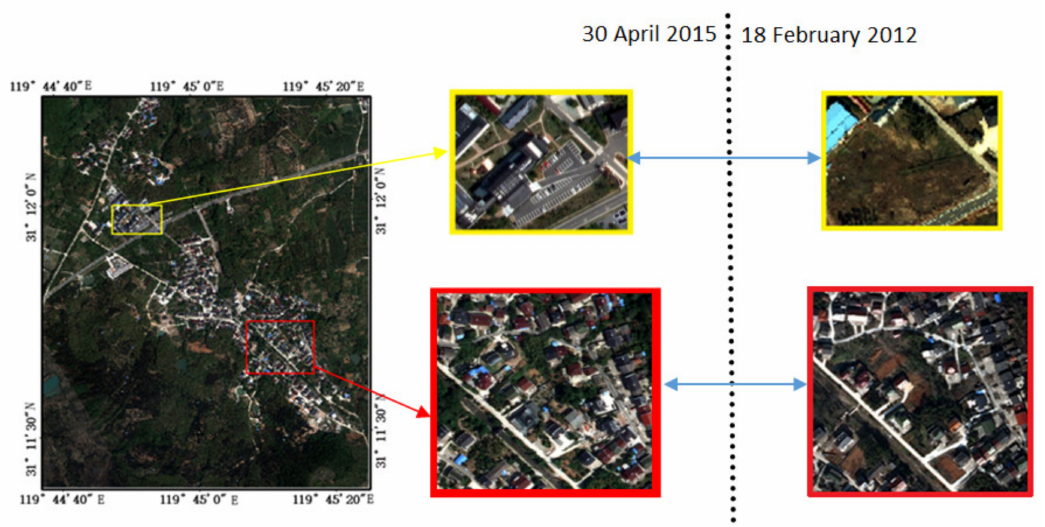
Figure 3. Experiment area.